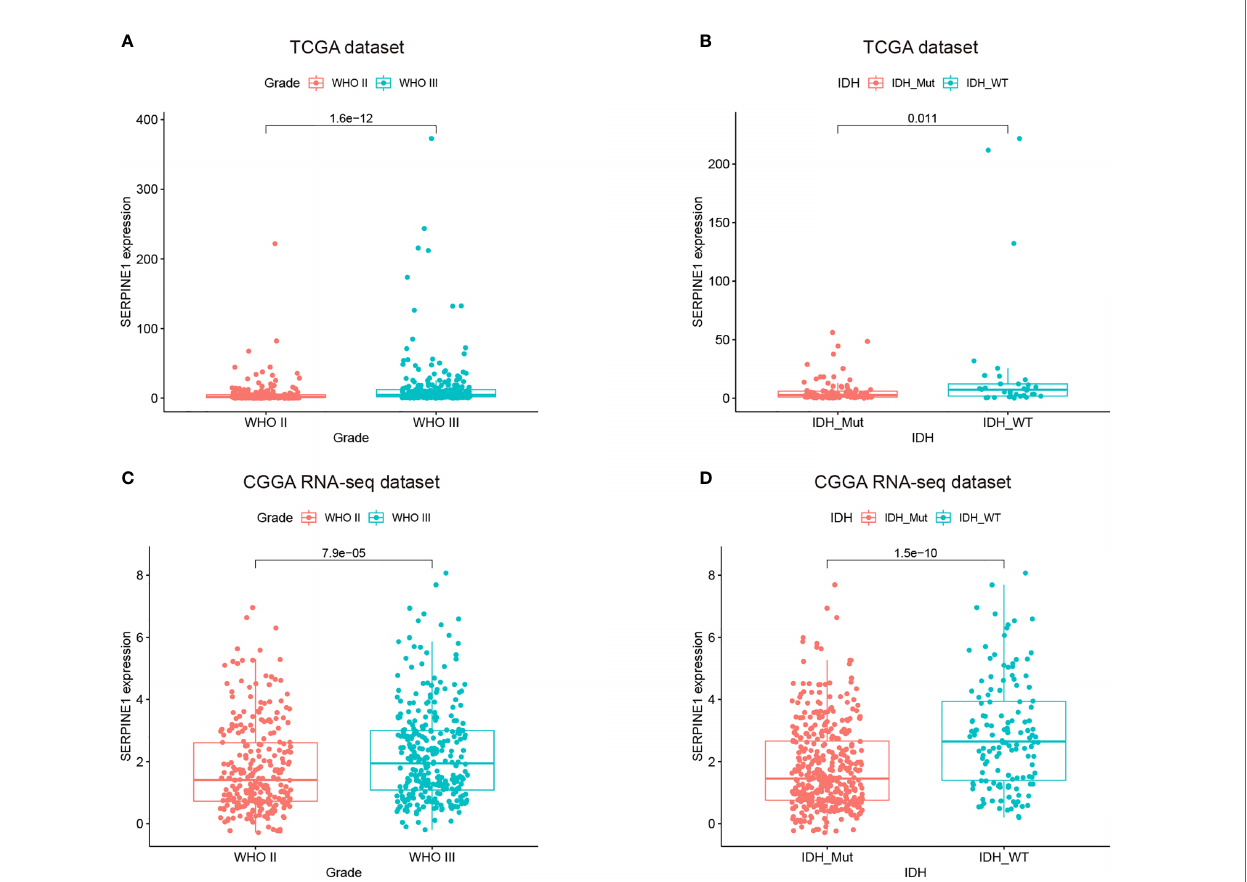
FIGURE 4 | The expressions of SERPINE1 increased with the grades of gliomas and was upregulated in the IDH wild-type LGGs. (A, C) SERPINE1 was highly expressed in WHO grade III glioma. (B, D) SERPINE1 was signi fi cantly elevated in IDH wild-type